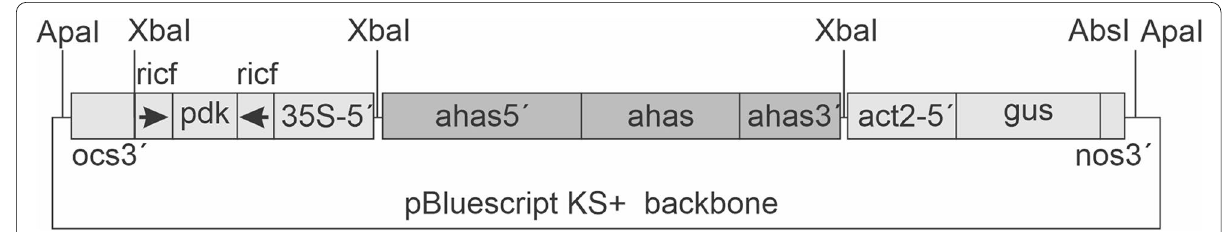
Fig. 1 Diagram representing the vector pRicRNAi used to obtain the transgenic castor bean event TB14S-5D. The vector contains the ahas gene (ahas5 ′ : ahas gene promoter; ahas: A. thaliana AHAS coding sequence; ahas3 ′ : ahas gene terminator), the intron-hairpin cassette to silence ricin endogenous genes (35S-5 ′ : 35S promoter of Cauliflower mosaic virus ; pdk: Flaveria trinervia pdk intron; ocs3 ′ : octopine synthase terminator from Agrobacterium tumefaciens , ricf: 460-bp ricin gene fragments cloned in sense and antisense orientations) and the gus gene (act2-5 ′ : actin 2 promoter from A. thaliana ; gus: β-glucuronidase coding region; nos3 ′ : nopaline synthase terminator from A. tumefaciens